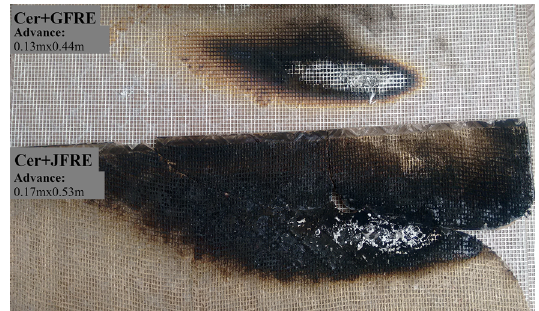
Figure 10. Comparison of the conjoint composites after the flame propagation test.